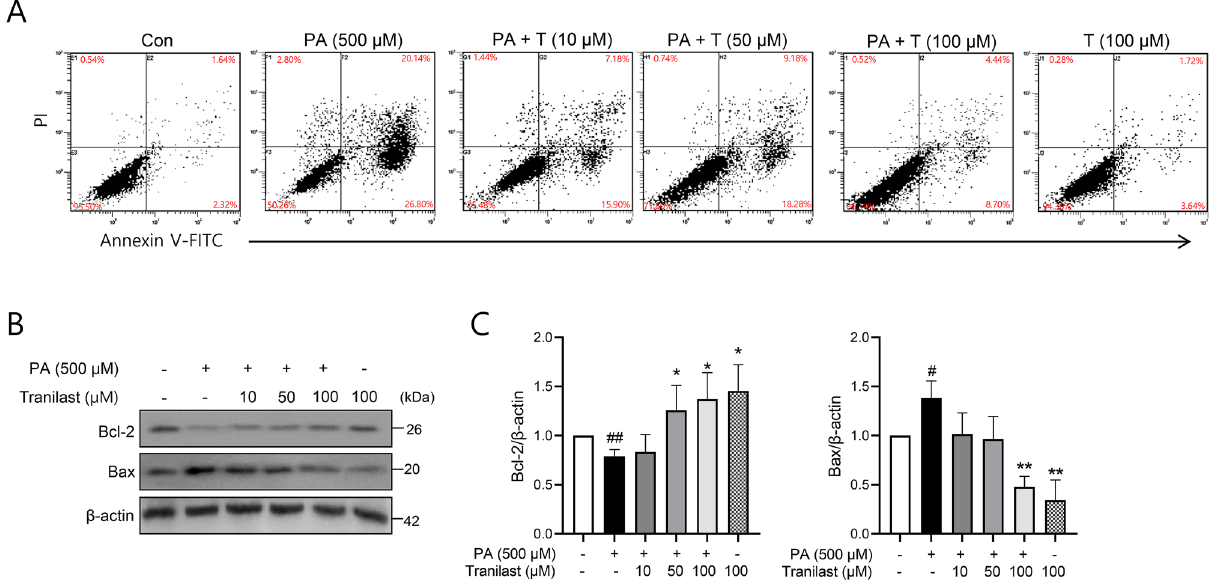
Figure 2. Tranilast reduces PA-induced apoptosis in INS-1 cells. ( A ) INS-1 cells were treated with PA (500 μM) in the presence or absence of tranilast at the indicated concentrations. The apoptotic rate of INS-1 cells